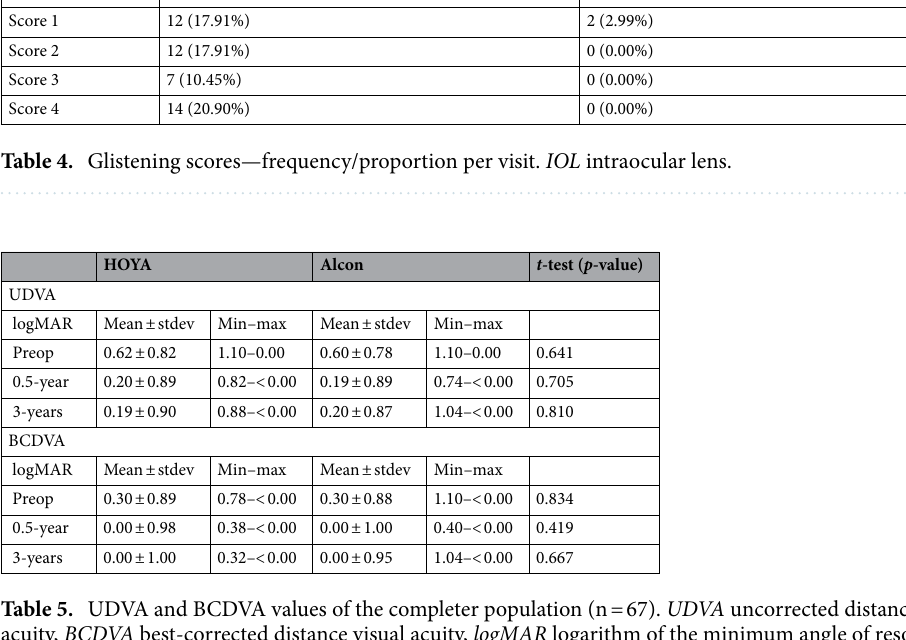
Number of patients and percentage (%) implanted with Glistening scores Alcon IOL